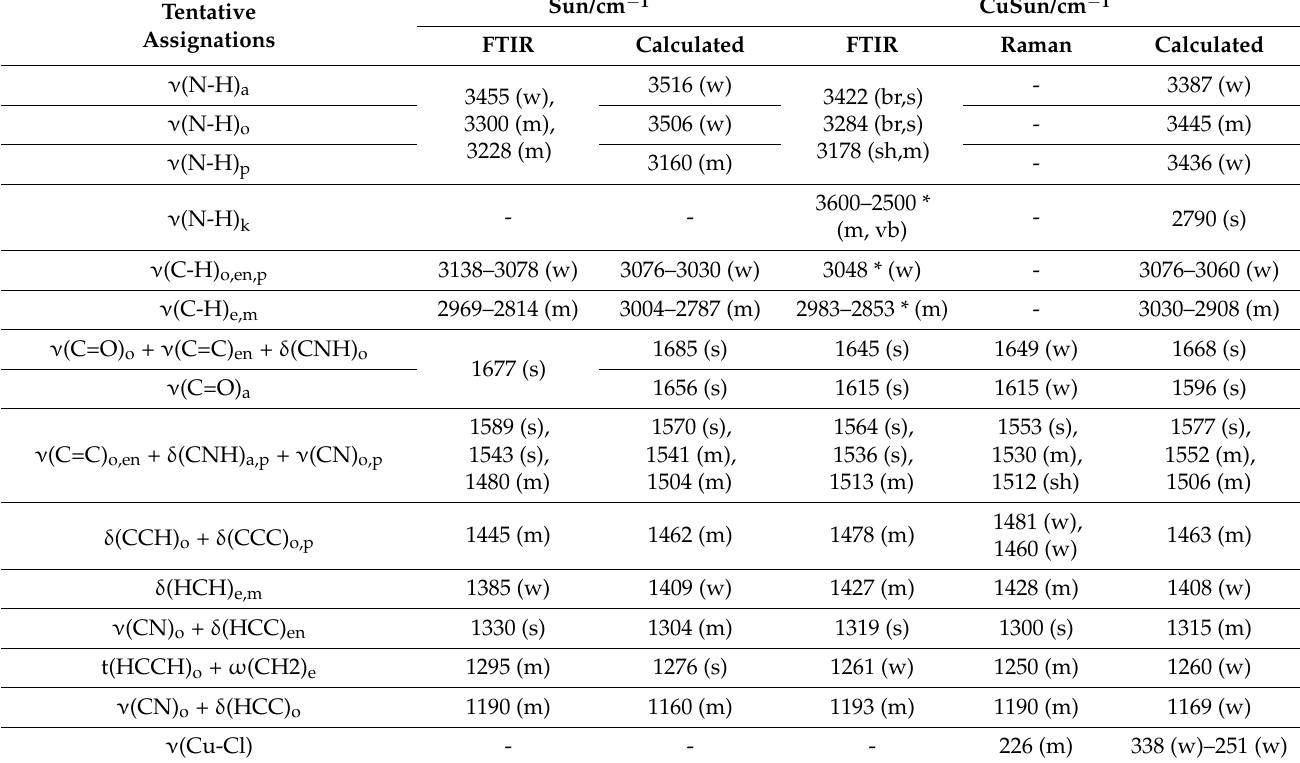
Table 3. Comparison of the main changes observed in the experimental and calculated vibrational frequencies, assignments and FTIR and Raman intensities for sunitinib (Sun) and its copper(II) complex (CuSun). Wavenumbers are in cm − 1 and the experimental intensities are